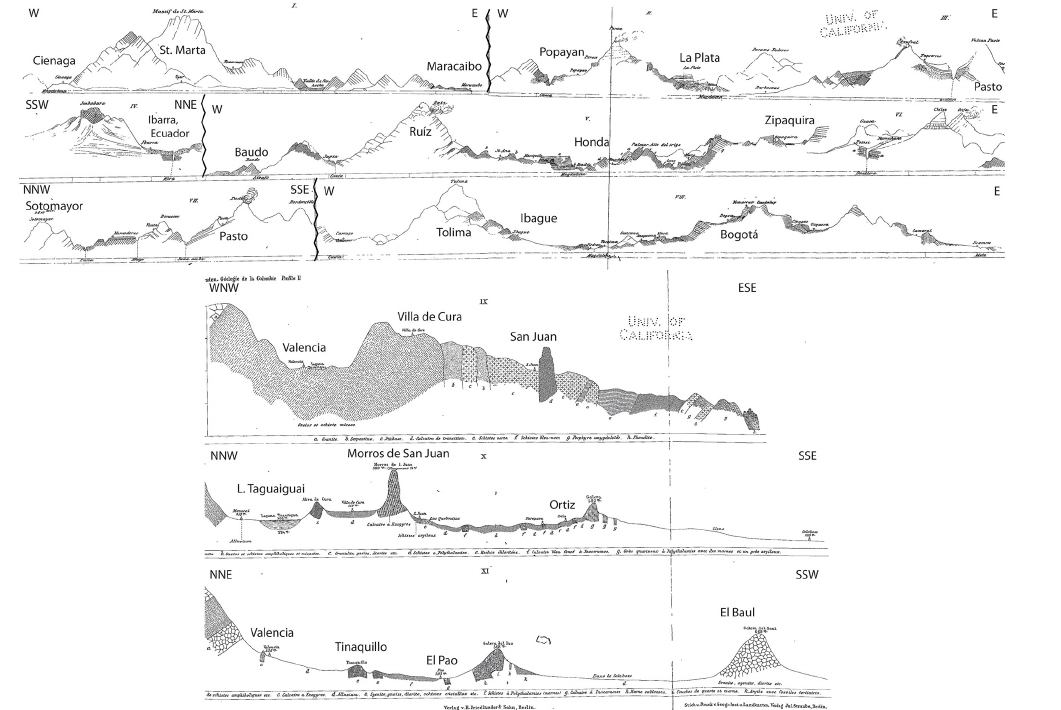
Figure 6. Karsten’s 1886 geologic profiles across parts of Colombia, Venezuela and Ecuador. Additions of place names and approximate geographic coordinates made by Aalto for clarity. Vertical zigzag lines separate different profiles. Approximate bedding orientation for layered rocks is shown beneath the land profiles. Active volcanoes are given plumes. Lithologies are given in fine print beneath the lower three profiles, all near Valencia,